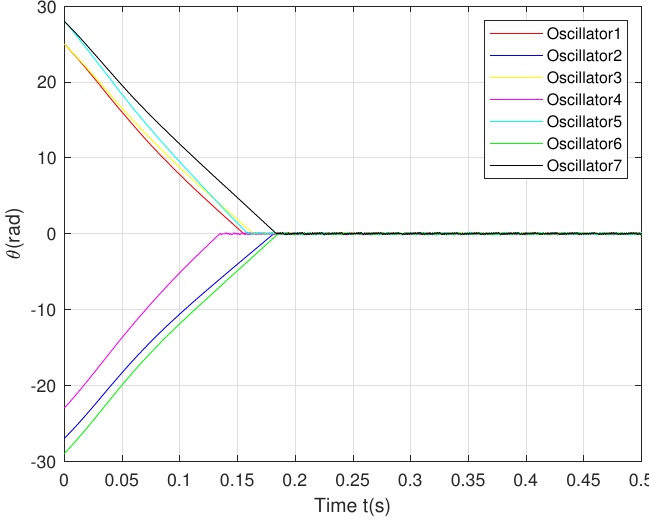
Figure 1. The sample path of the solution to system